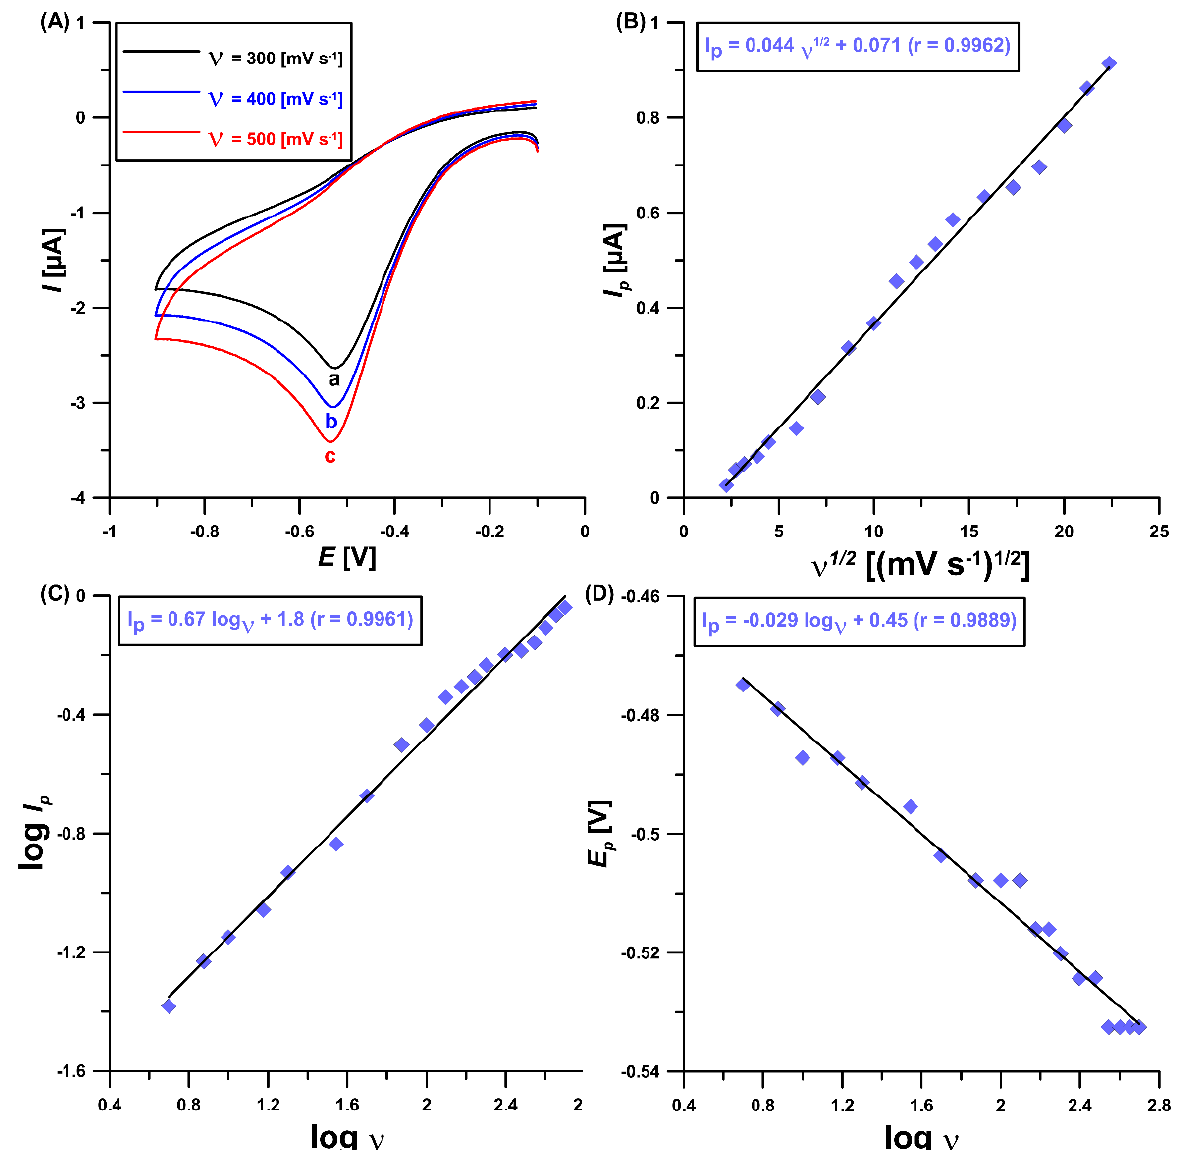
Figure 3. ( A) CV curves of 5 µM ROX in 0.05 M NaAc – HAc buffer (pH = 5.6) and 40 mg/L CTAB at the GCE/CTAB. The relationship between ( B ) I p and υ 1/2 ( υ from 5 to 500 mV/s), ( C ) log I p and log υ and ( D ) E p and log υ .